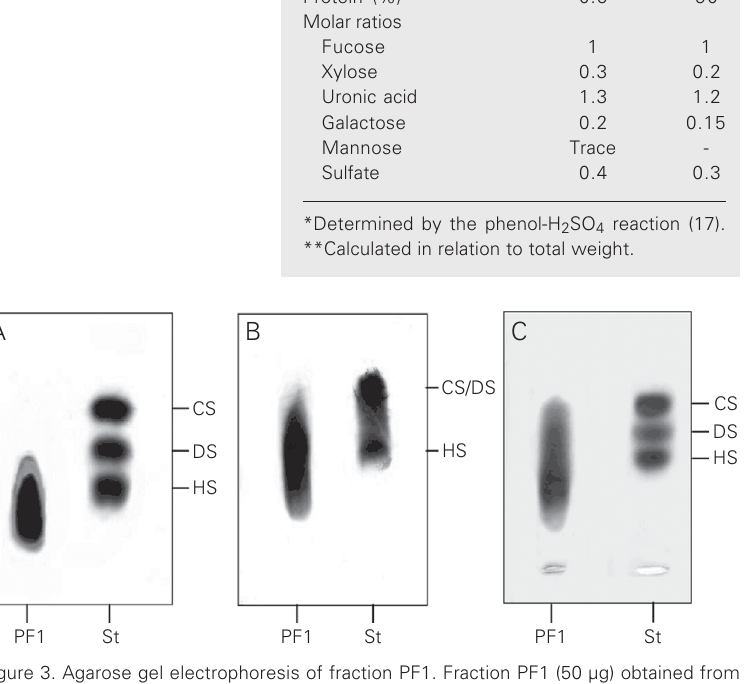
Figure 3. Agarose gel electrophoresis of fraction PF1. Fraction PF1 (50 µg) obtained from the Sephadex G-75 column was subjected to electrophoresis in 40 mM barium acetate buffer, pH 4.0 (A); 50 mM sodium phosphate buffer, pH 8.0 (B); 50 mM diaminopropane/ acetate buffer, pH 9.0 (C) as described in Material and Methods. St = standard of glycosaminoglycans: chondroitin sulfate (CS), dermatan sulfate (DS) and heparan sulfate (HS), 5 µg each.